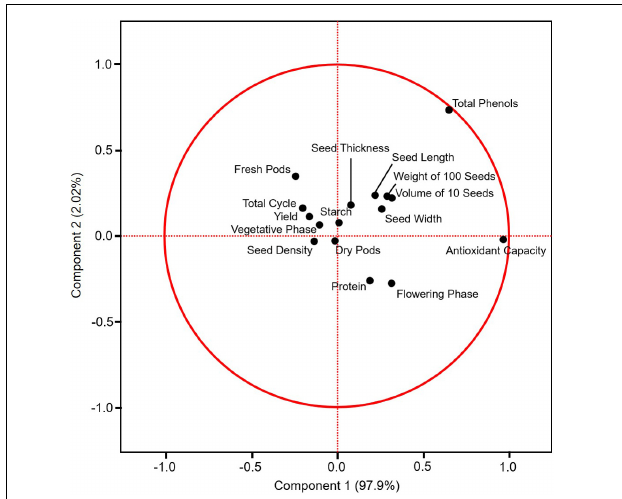
FIGURE 5 | Principal component analysis (PCA) on the covariance of yield and the other variables of climbing accessions assessed in this study (i) and the clustered correlation between the variables